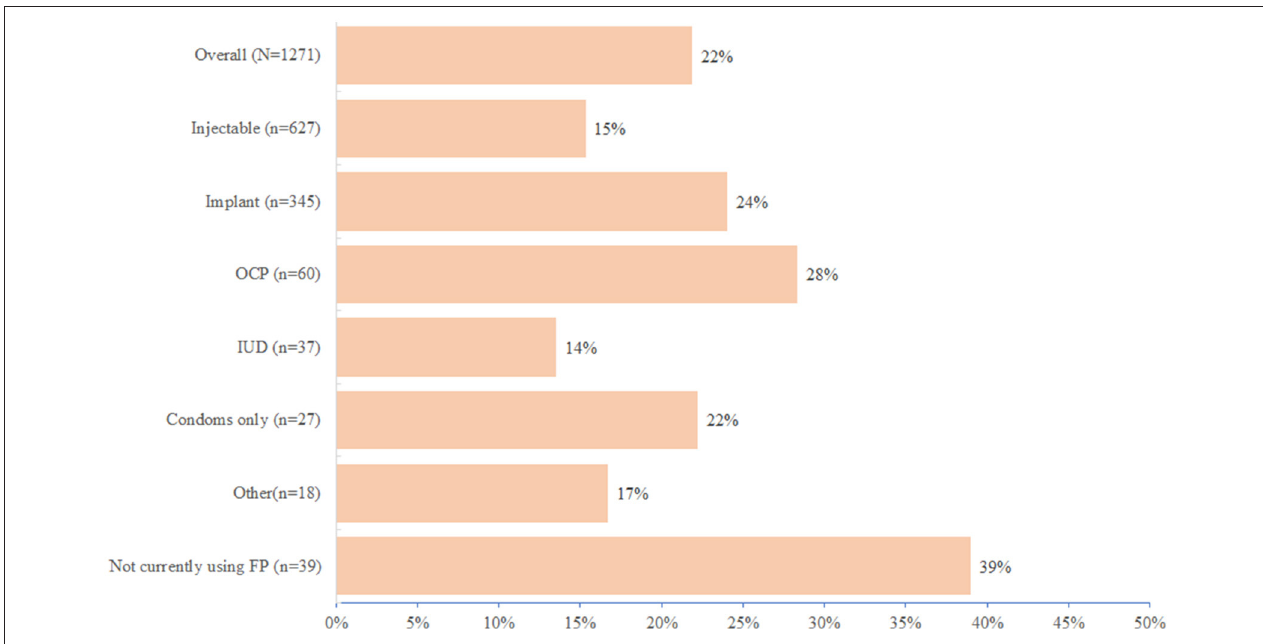
FIGURE 1 | Frequency of PrEP initiation by contraception method